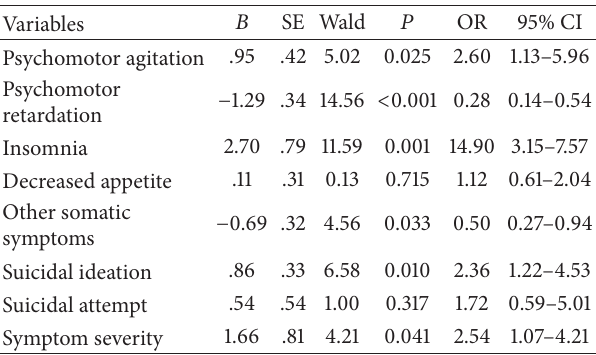
Table4:Logisticregressionanalysisofdepressivesymptomspattern in PMD versus